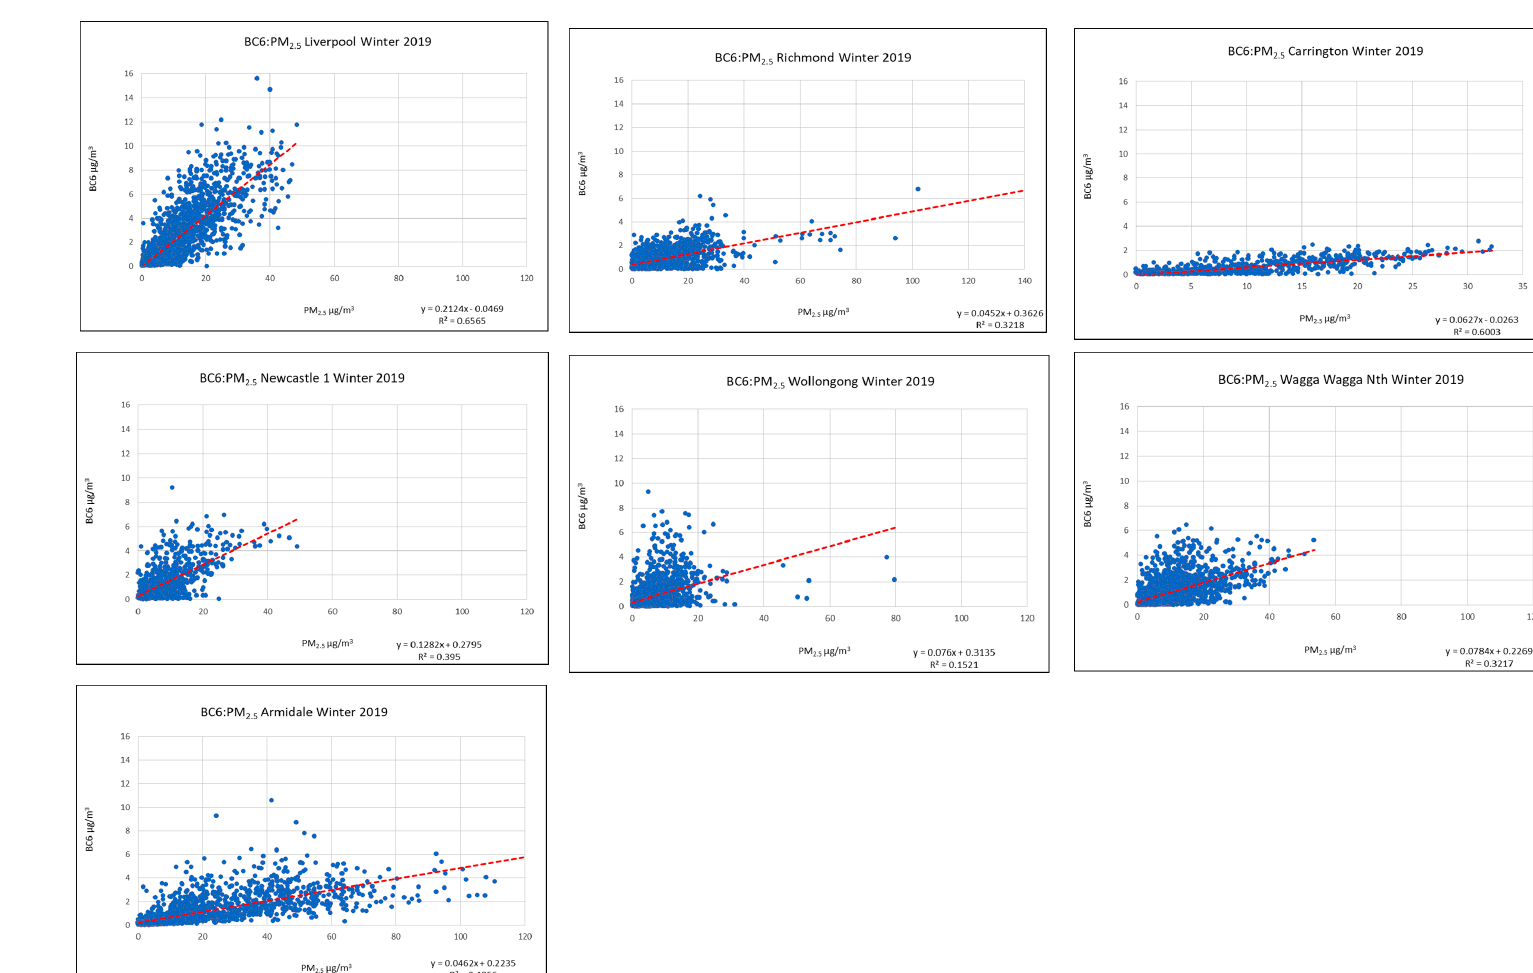
Figure 4. Regression of BC versus PM 2.5 for 2019 winter period at Liverpool, Richmond (Sydney region), Carrington, Newcastle (Lower Hunter region), Wollongong (Illawarra region), Wagga Wagga North and Armidale in regional New South